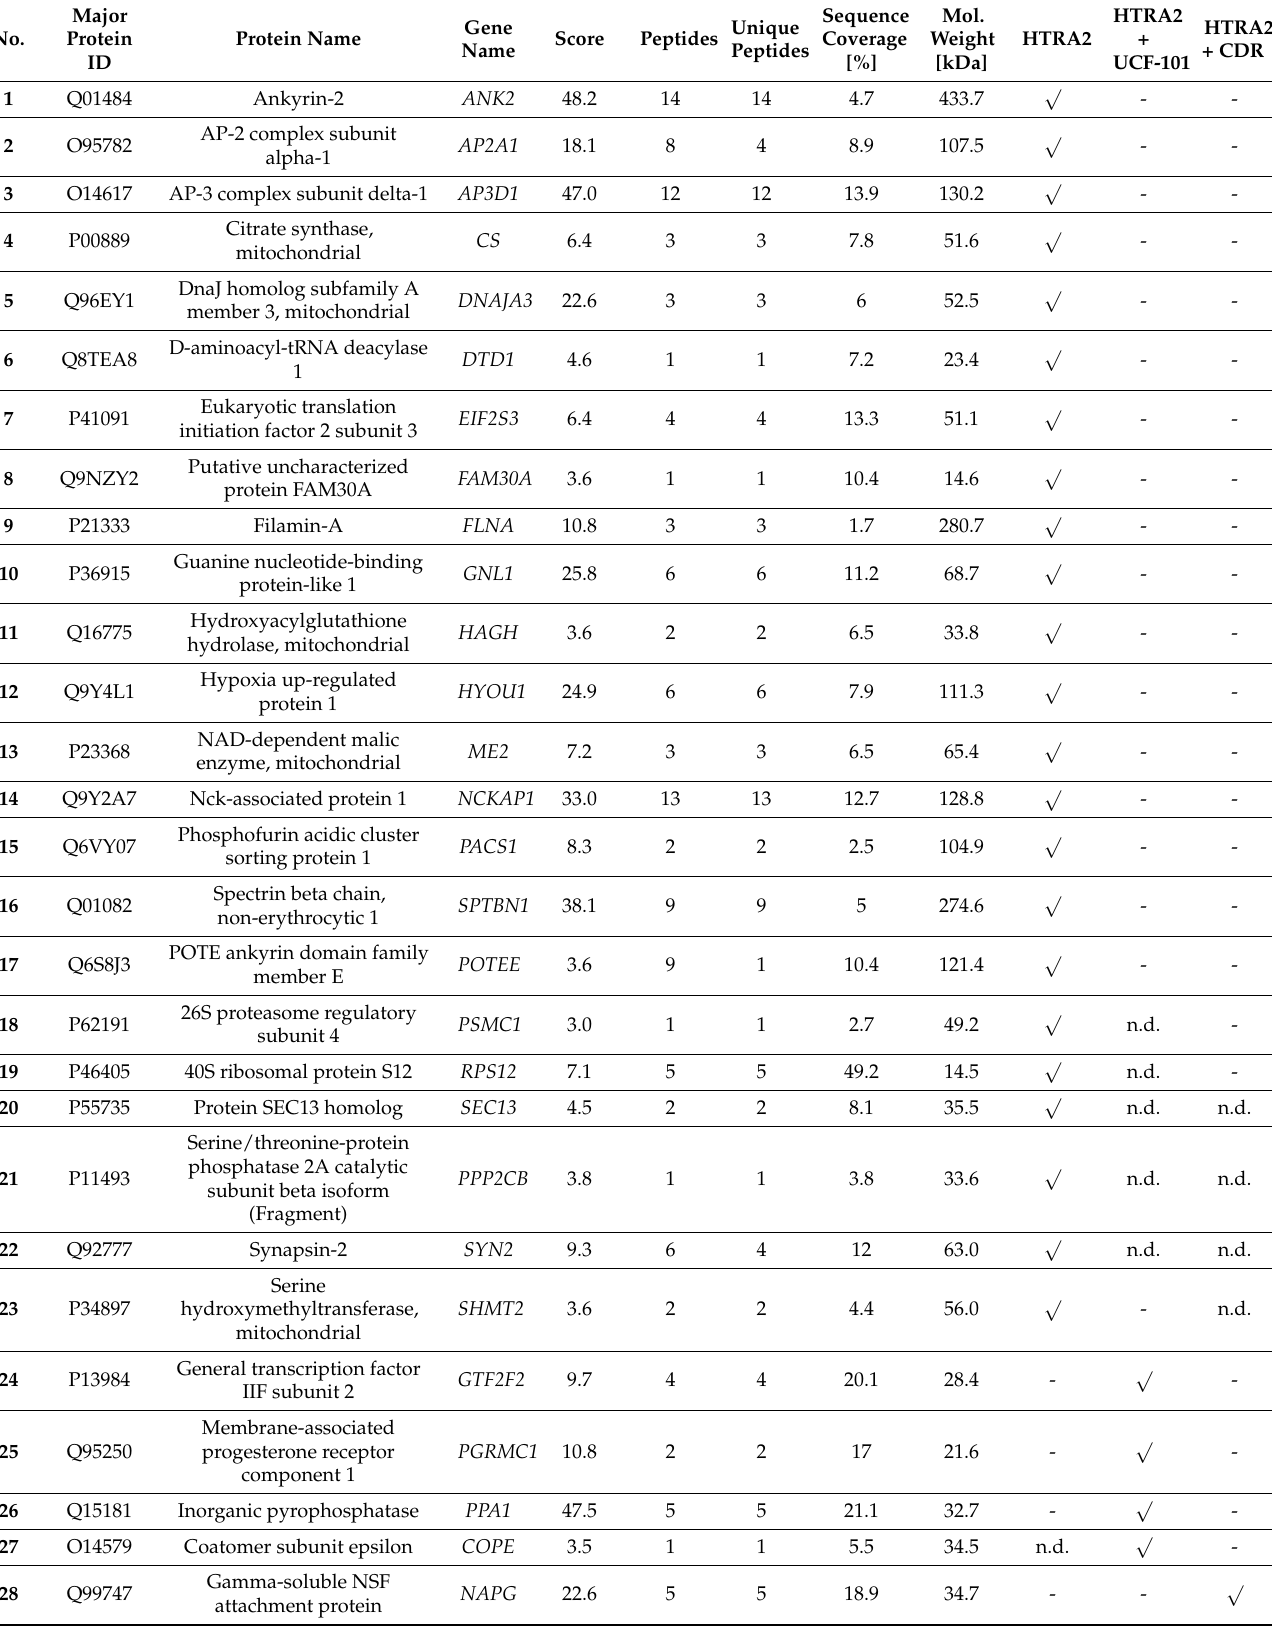
Table 1. Significant protein interaction partner of the serine protease HTRA2 identified in the HTRA2 group, the HTRA2 + UCF-101 group, and the HTRA2 + CDR